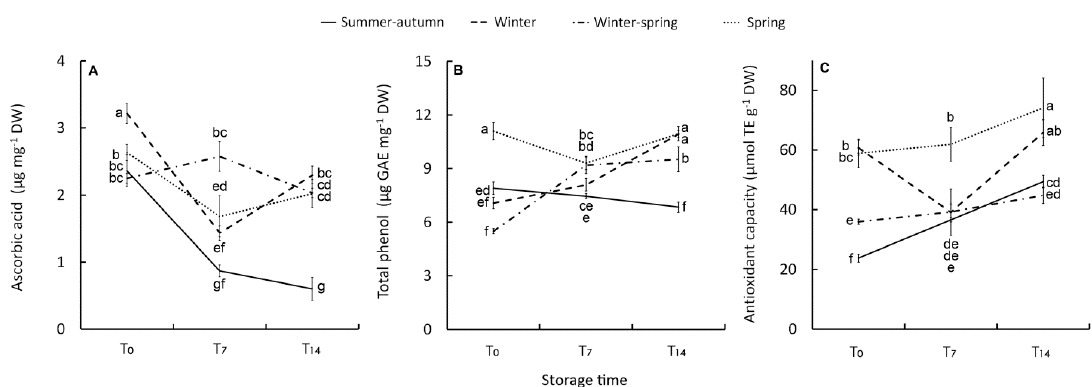
Figure 4. E ff ect of growing cycle on ascorbic acid ( A ) and total phenol concentration ( B ) and on antioxidant capacity ( C ) of the raw heads (T 0 ), 7 days (T 7 ) and 14 days (T 14 ) stored product. Vertical bars ( ± SE of mean) ( n = 9) with di ff erent letters are significantly di ff erent according to the Least Significant Di ff erence test ( P = 0.05). GAE = gallic acid equivalent. TE = Trolox equivalent.